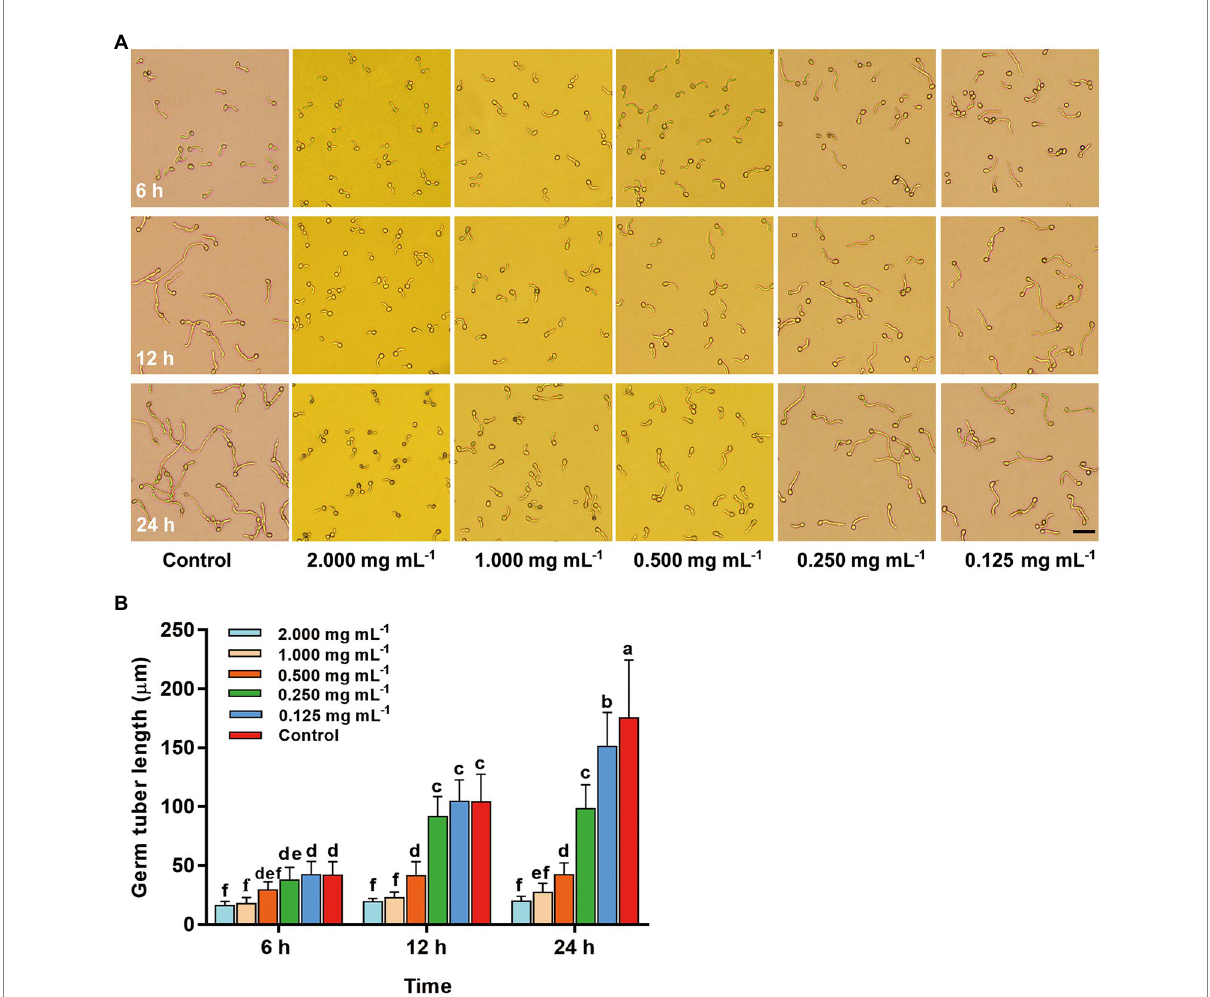
FIGURE 8 Changes of conidia and germ tubes of B. cinerea after treated with different concentrations of compound 2 in 24 h. (A) Images for morphological changes of conidia and germ tubes in different treatments Bar = 100 μ m. (B) Inhibitory effect of compound 2 against germ tube elongation of B. cinerea . Columns with different letters represent significant difference at p <